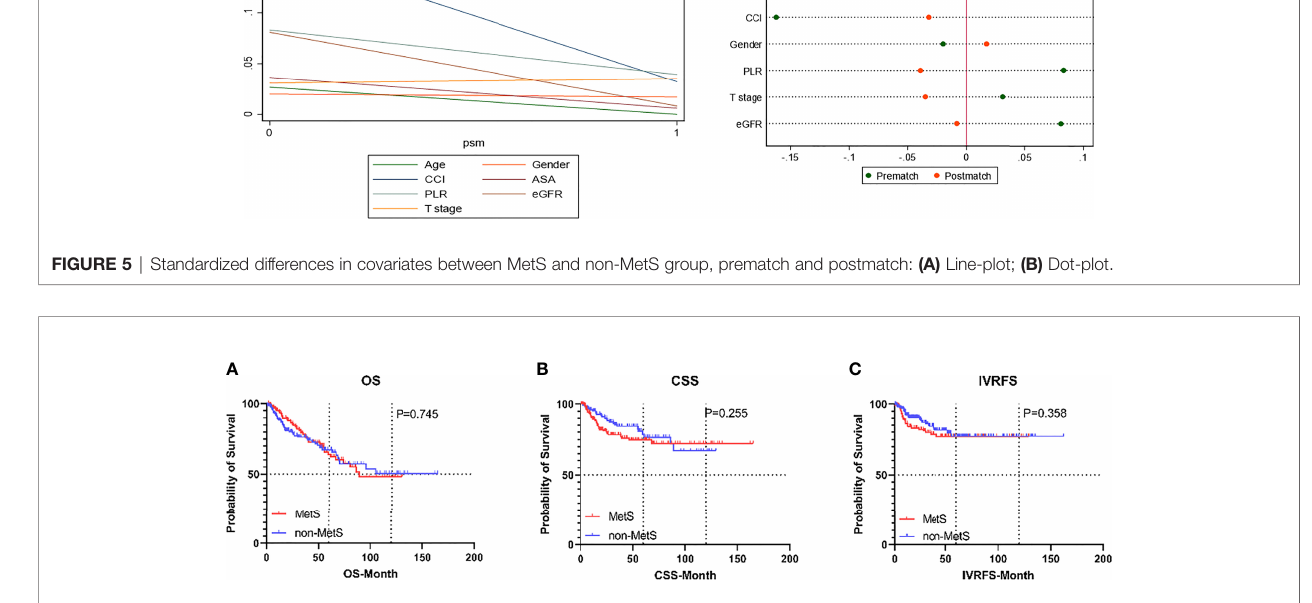
FIGURE 6 | Kaplan-Meier curves for survival outcomes in UTUC patients according to the presence of MetS after propensity score matching. (A) OS, (B) CSS, and (C) IVRFS. OS, overall survival; CSS, cancer-speci fi c survival; IVRFS, intravesical recurrence-free